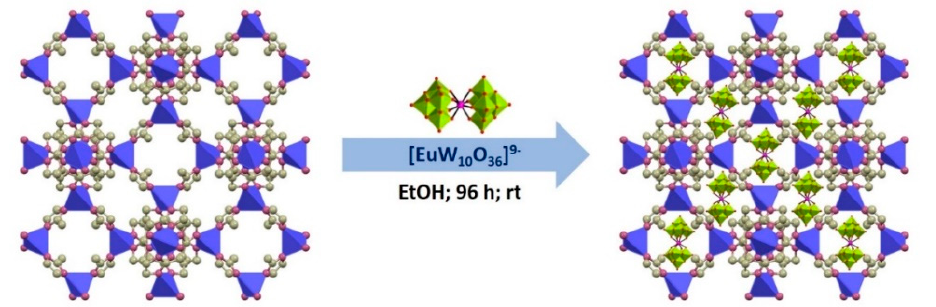
Scheme 1. Representation of the preparation of the EuW 10 @ZIF-8 composite material. Room temperature is abbreviated as rt.